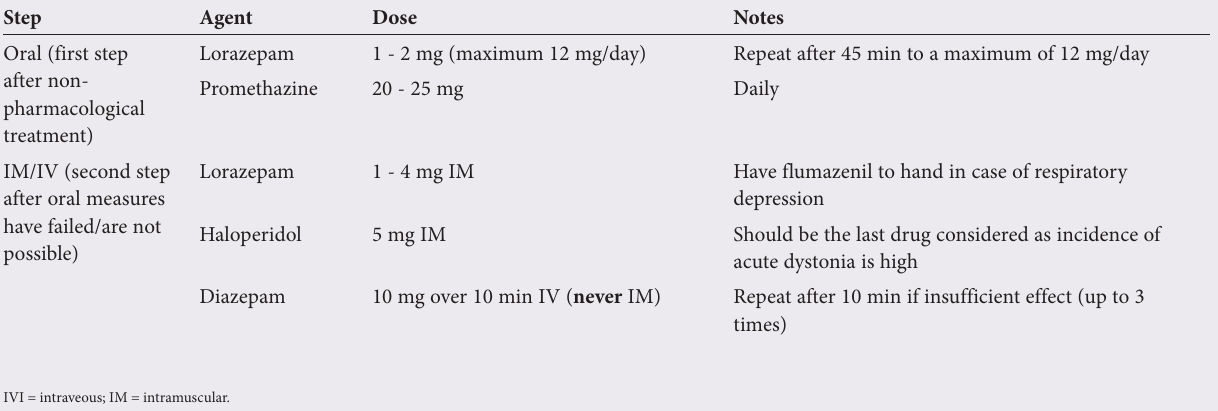
Table 5. Approach to prescribing psychotropics for the agitated